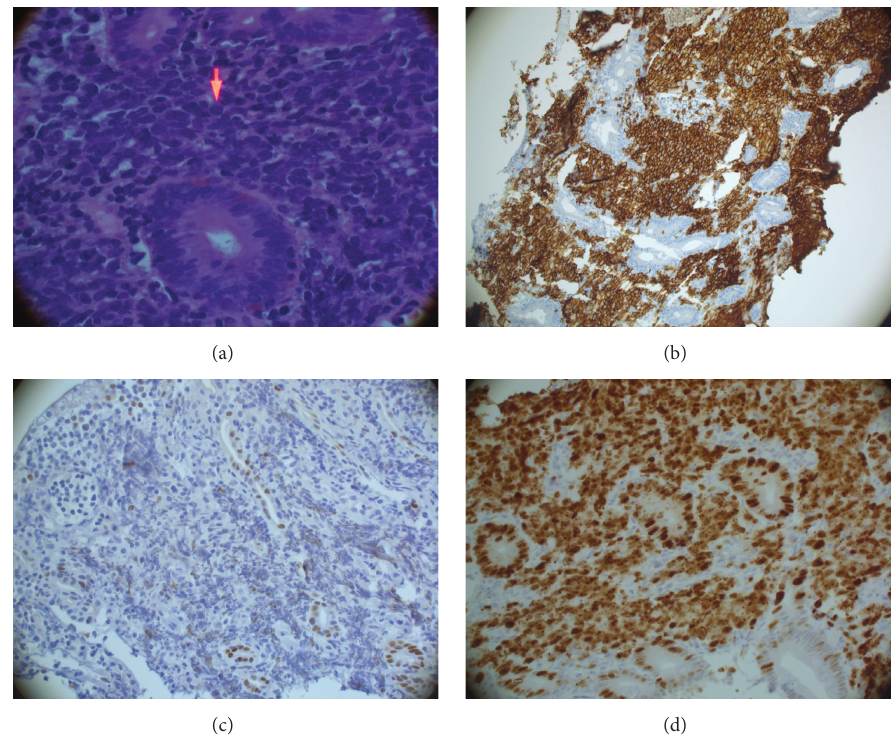
Figure 3: (a) High power (400x), H&E (hematoxylin and eosin), medium to large lymphoid cells invading the lamina propria featuring multiple nucleoli (arrow) consistent with high grade lymphoma (Burkitt’s lymphoma shows multiple nucleoli). (b) CD20 highlights lamina propria atypical lymphoid infiltrate, consistent with high grade B-cell lymphoma. (c) Negative staining for MYC immunohistochemical stain. (d) 100% nuclear positivity for Ki-67, consistent with high proliferation rate.